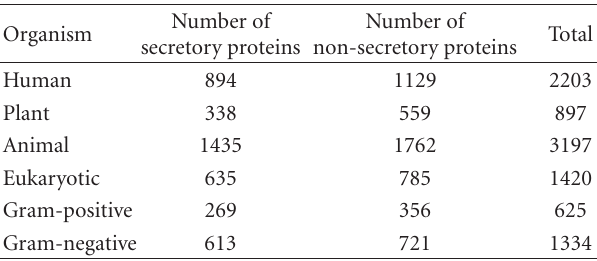
Table 2: Sampling proportion of S − in each of the six di ff erent organism